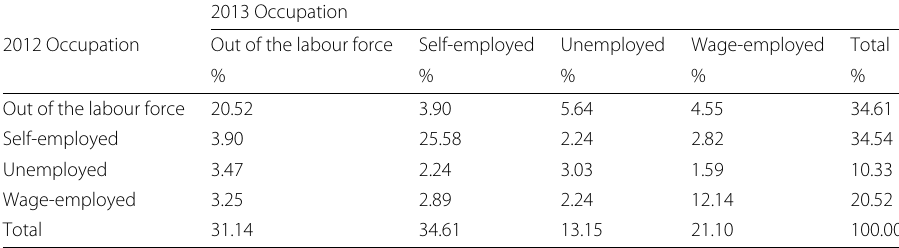
Table 3 Transition matrix for women